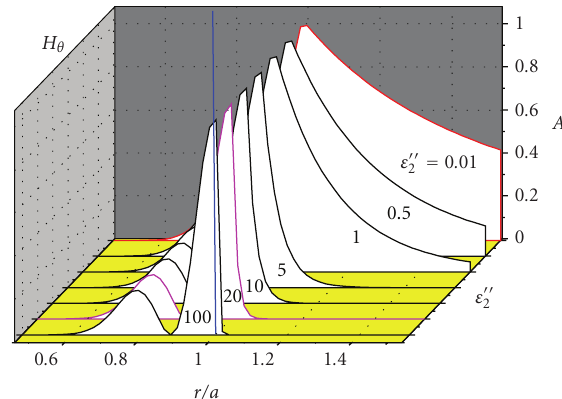
Figure 6: Normalized distribution of electromagnetic field com- ponent H θ for the dielectric ball in high loss medium. The relative radial distance r/a is along the horizontal axis. The ball border is a vertical solid line, ε (cid:2) 2 = 20. The numbers denote values ε (cid:2)(cid:2) 2 = 0 .